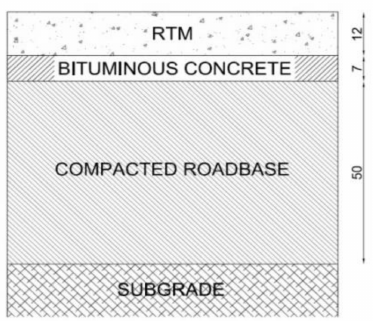
Figure 2. First trial section pavement’s